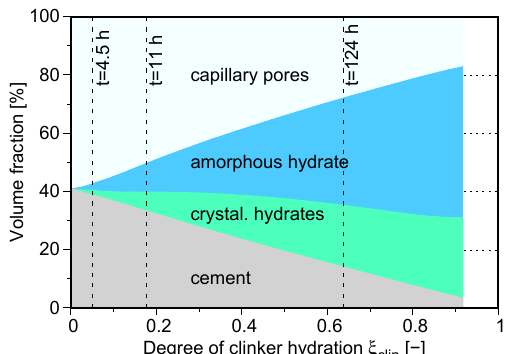
Figure 3. The volume fraction evolution of microstructural phases in cement ID 133, cured at 20 °C in saturated conditions, as simulated by CEMHYD3D.